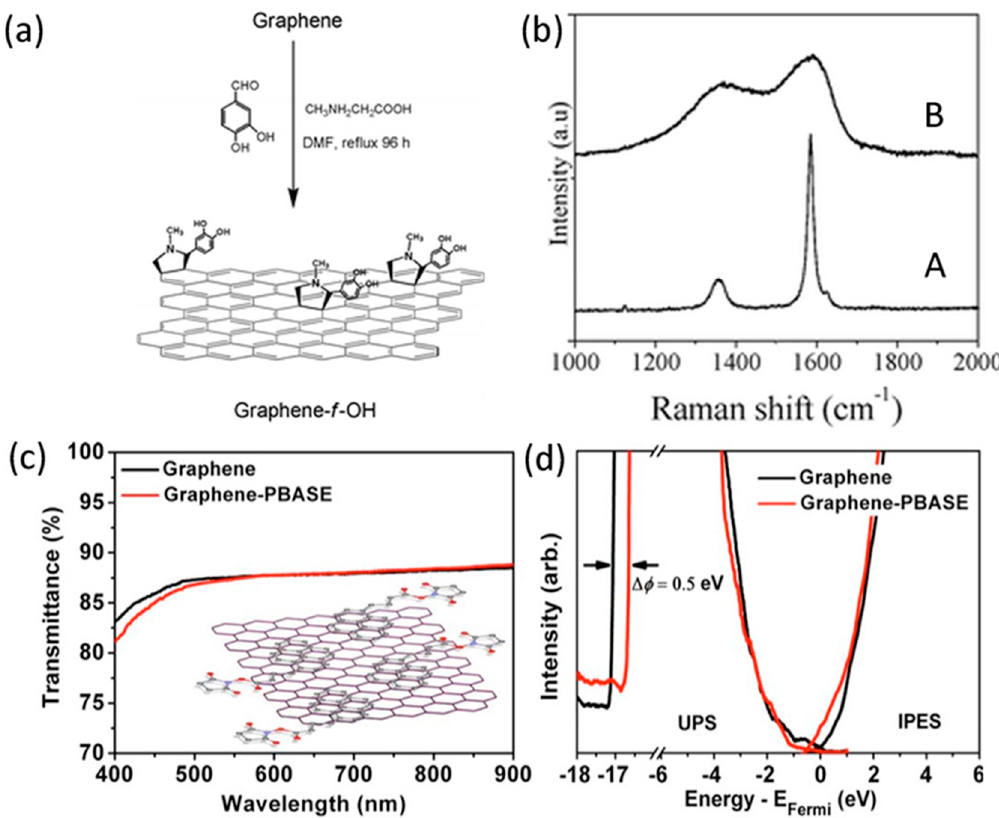
Figure 3. ( a ) Schematic diagram of modified functional groups on the surface of graphene. ( b ) Raman spectra of (A) starting graphene and (B) graphene- f -OH. Transmission spectrum. Reproduced from [65] with the permission from Royal Society of Chemistry. ( c ) and UPS and IPES combined spectrum. ( d ) of graphene film before and after modification. Inset in ( c ): schematic diagram of PBASE modified graphene. Reproduced from [66] with the permission from American Chemical Society.